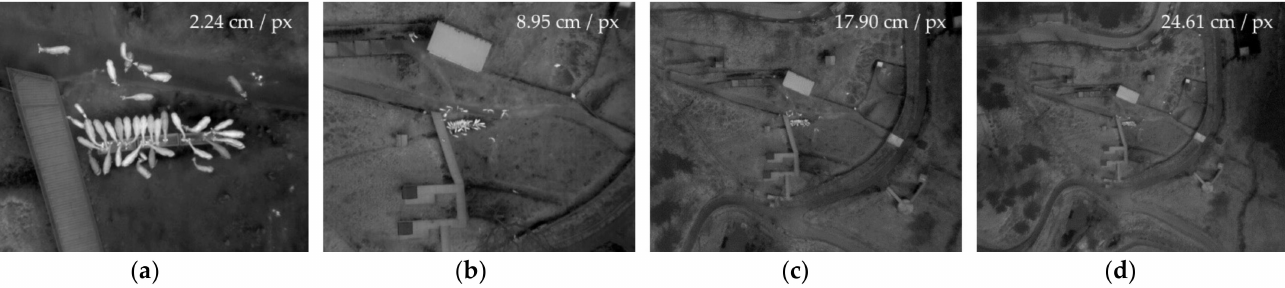
Figure 12. Thermal images taken at shooting heights of ( a ) 25 m, ( b ) 100 m, ( c ) 200 m, and ( d ) 275 m, and their pixel